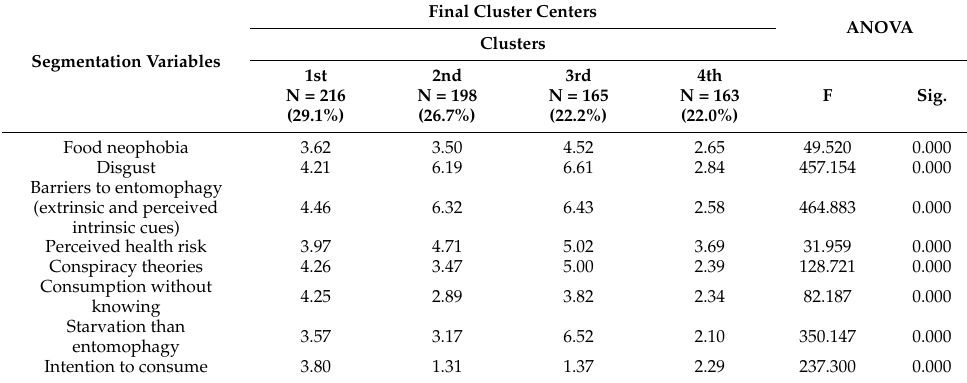
Table 5. Segments of the Z cohort based on barriers of